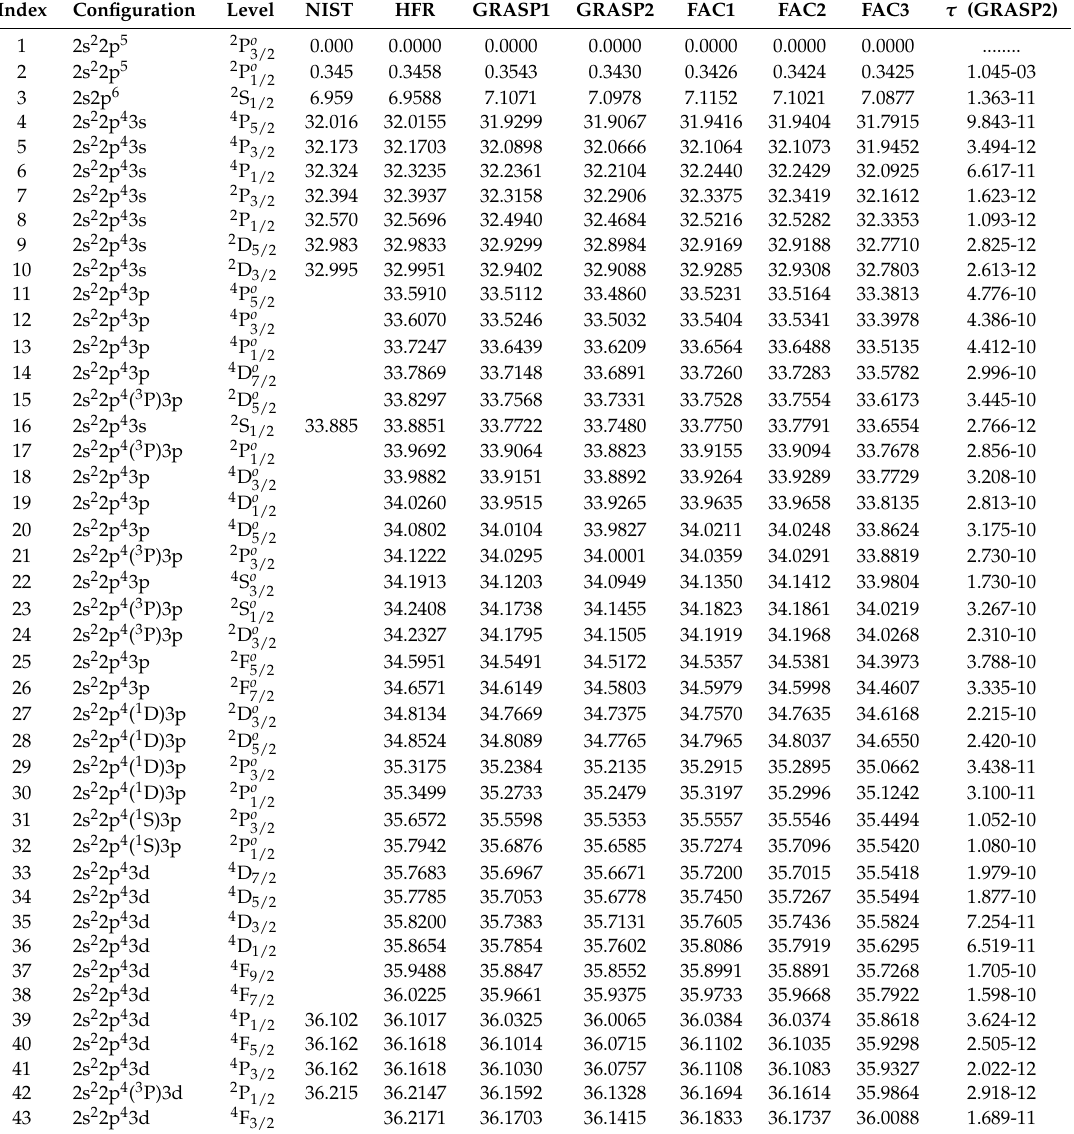
Table 1. Energies (in Ryd) and lifetimes ( τ , s) for the lowest 102 levels of Sc XIII. a ± b ≡ a × 10 ± b